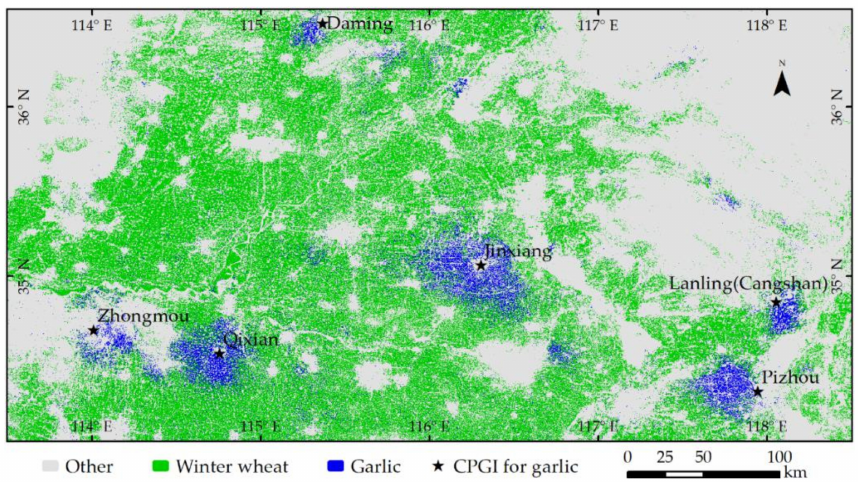
Figure 6. The final garlic and winter wheat map (FGWM) from 2020 in the study